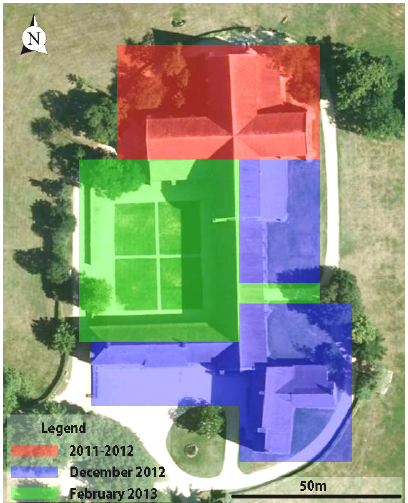
Figure 4. TLS acquisition plane during the three campaigns, superimposed on an aerial view (IGN BD Ortho®).